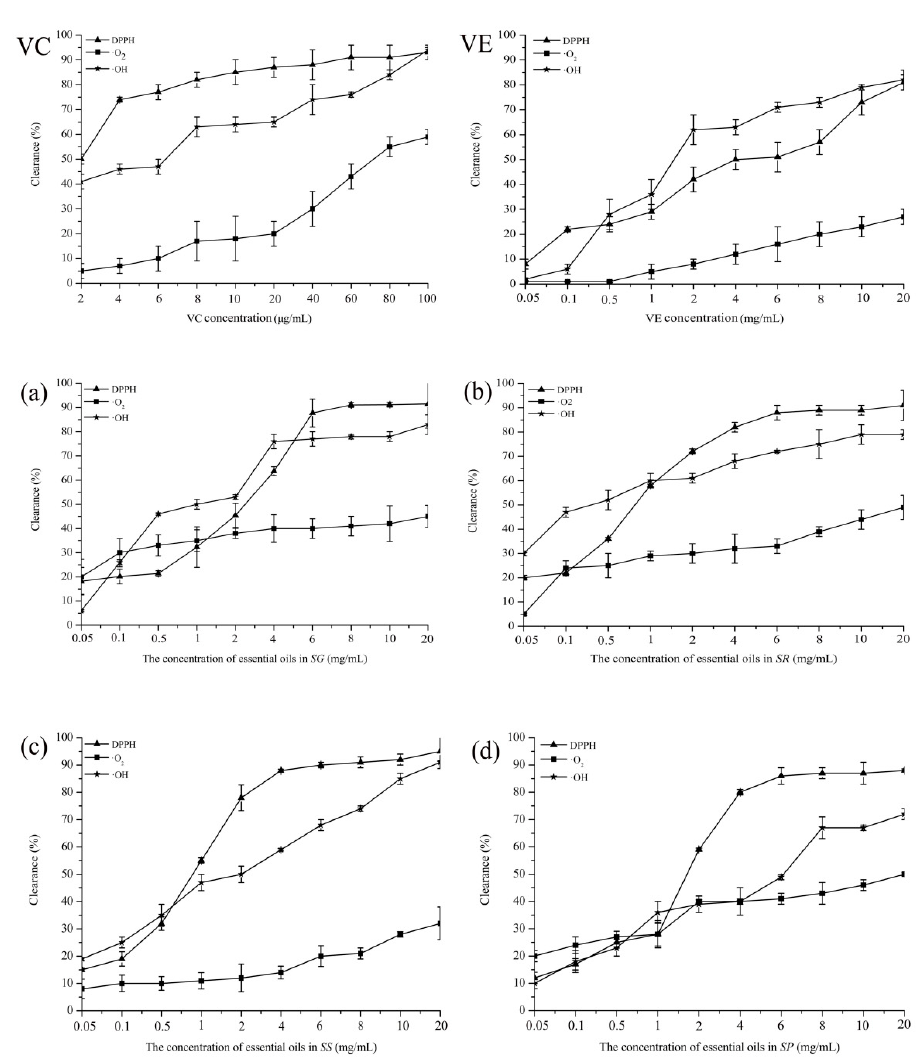
Figure 3. The results of free radical scavenging activities of essential oils from four species (( a ) SG ; ( b ) SR ; ( c ) SS ; ( d ) SP ).